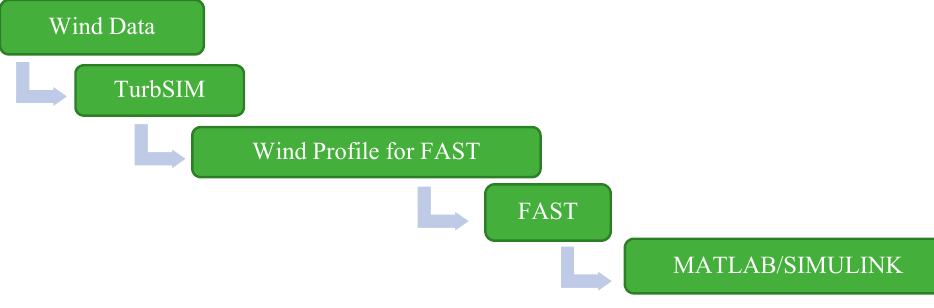
Figure 2. Stand-alone software tools integration process.